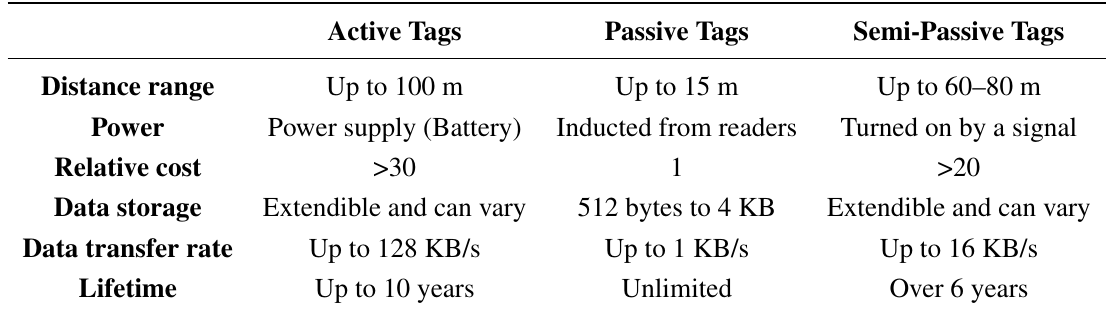
Table 2. Types of RFID